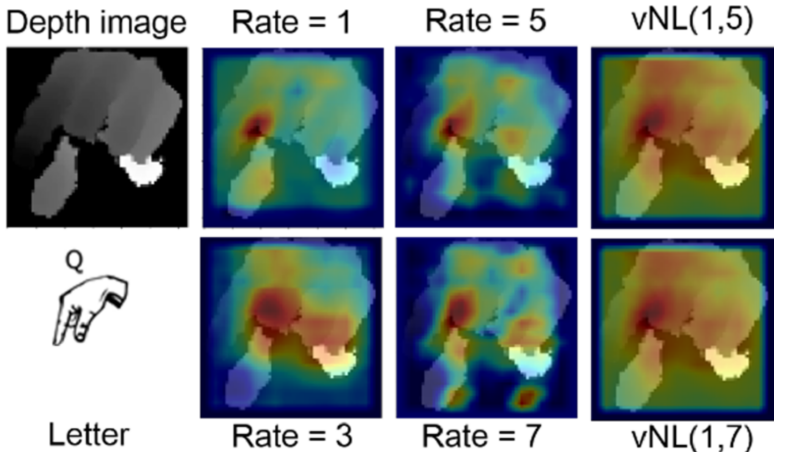
Figure 6. Visualization of outcomes of each branch from the NLRF block. The left-most column shows the depth image and its corresponding label. The middle two columns show the outcome of each branch of atrous convolution. vNL(1,5) and vNL(1,7) represent the outcomes of the vNL block determining the dependencies between the branches of atrous convolutions with rates 1 and 5 and rates 1 and 7,